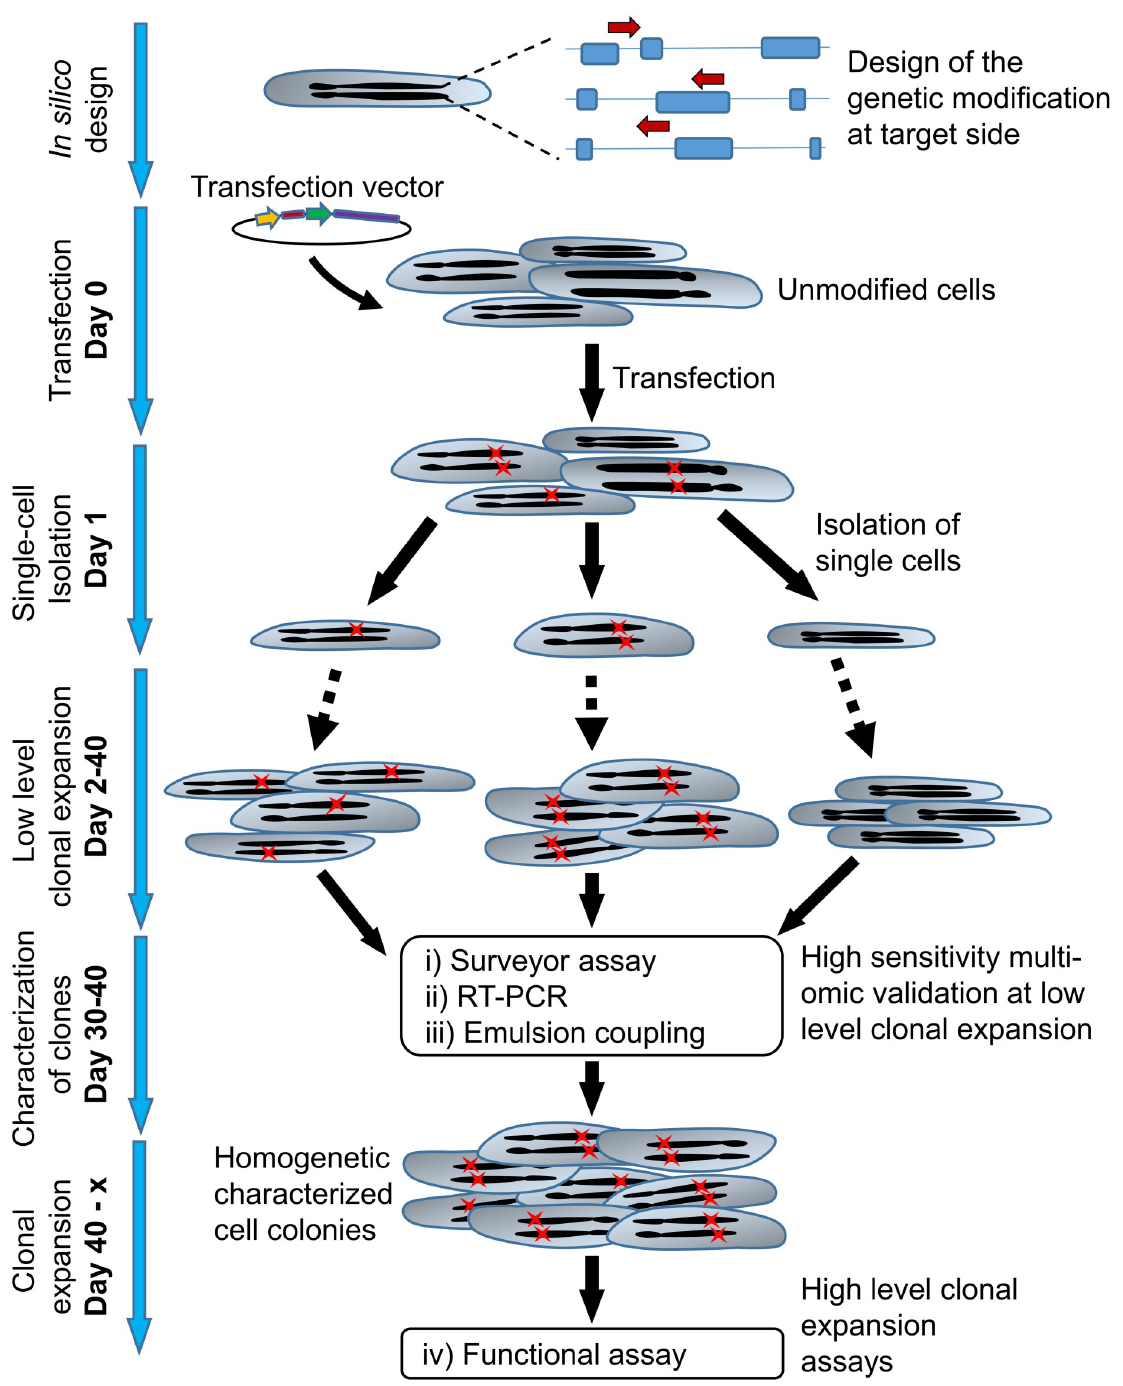
Fig 1. Improved workflow to establish and characterize CRISPR/Cas9 edited cells with minimal clonal expansion. gRNAs transfected cells were isolated and sorted by SCP detecting GFP signal. The days post-transfection are indicated. To characterize the introduced genetic changes, RNA, and protein expressions, a set of assays requiring a low number of cells was proposed: (i) Surveyor assay (DNA edits), (ii) RT-PCR (RNA expression), and (iii) Emulsion Coupling (protein expression). The selected clones are ready for further confirmatory assays (iv). Arrows indicate gRNAs, red crosses symbolize introduced genetic